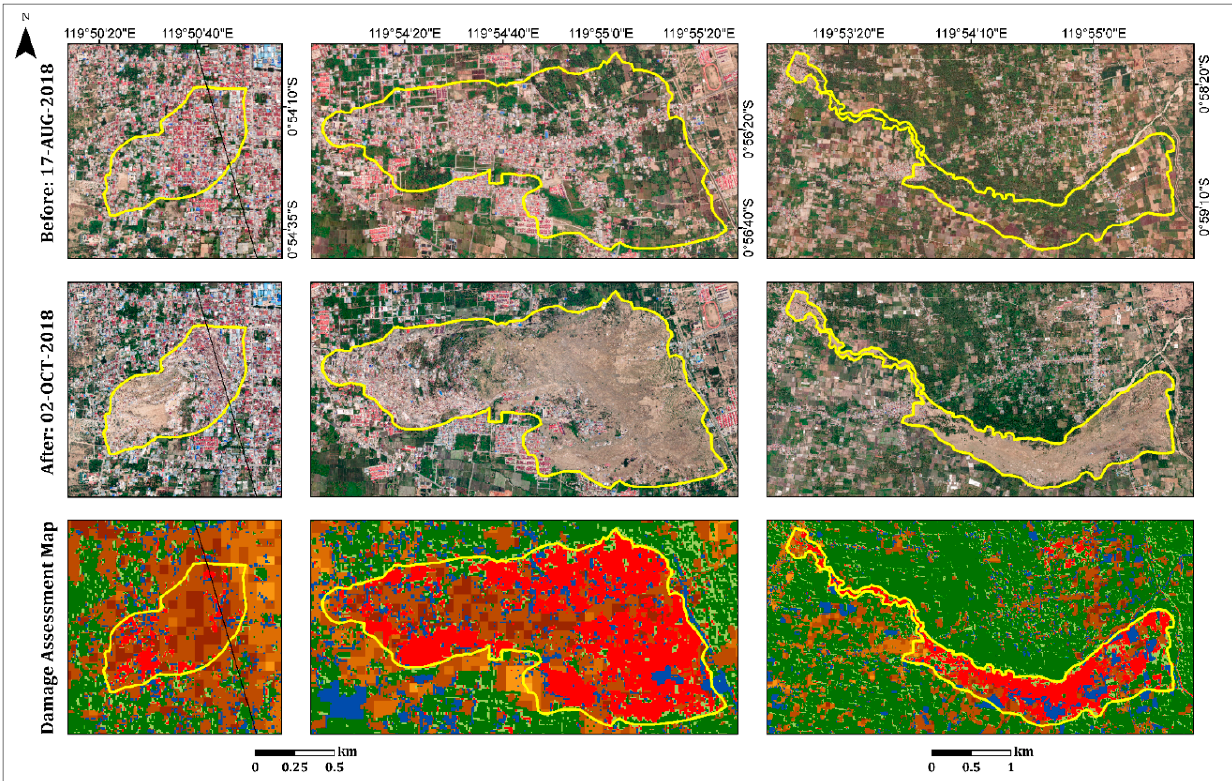
Figure 14. Insets showing the three villages ( left to right ): Balaroa, Petobo and Jono Oge. Pre-event optical image (17 August 2018), post-event optical image (2 October 2018), and the overall damage assessment map: structures and vegetation (see legend in Figure 13). Table 4. Summary of the damaged rural areas in Palu valley. Built-up, vegetation, and water body areas are included in the data. A detailed description of the damaged vegetation is provided along with the damage